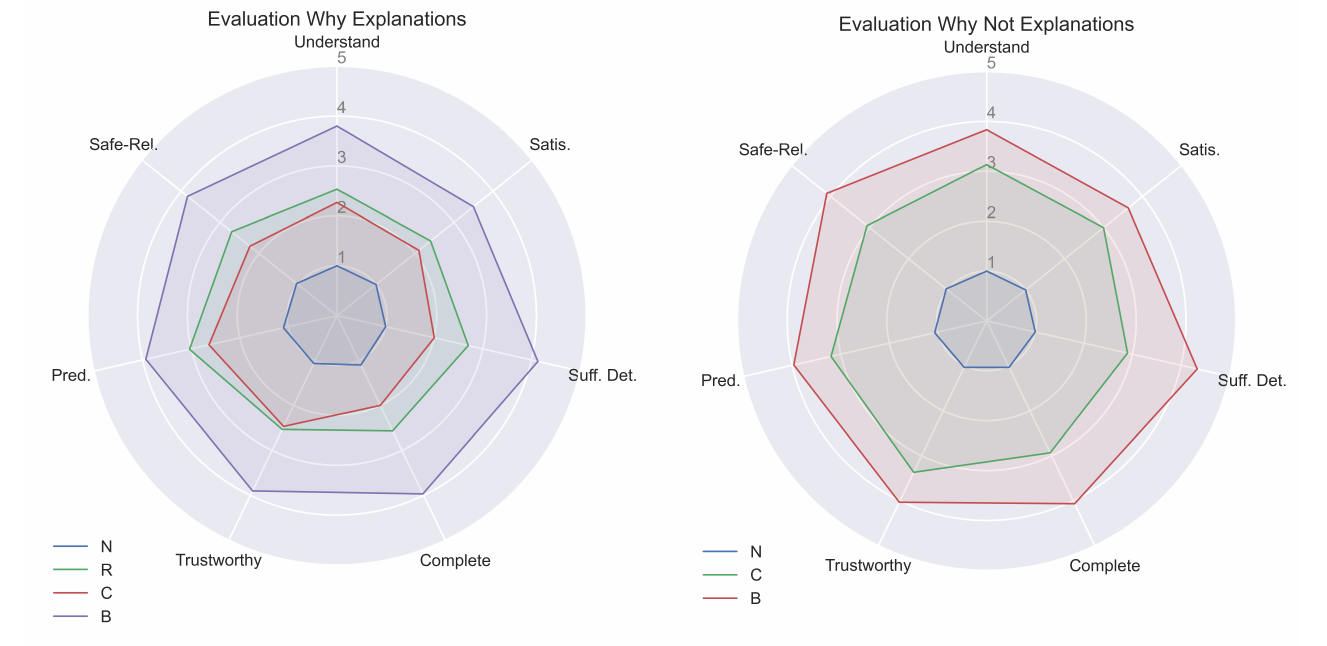
Figure 26. Radar Plot with the means of the scores achieved for each quality in both the “Why” and “Why not”